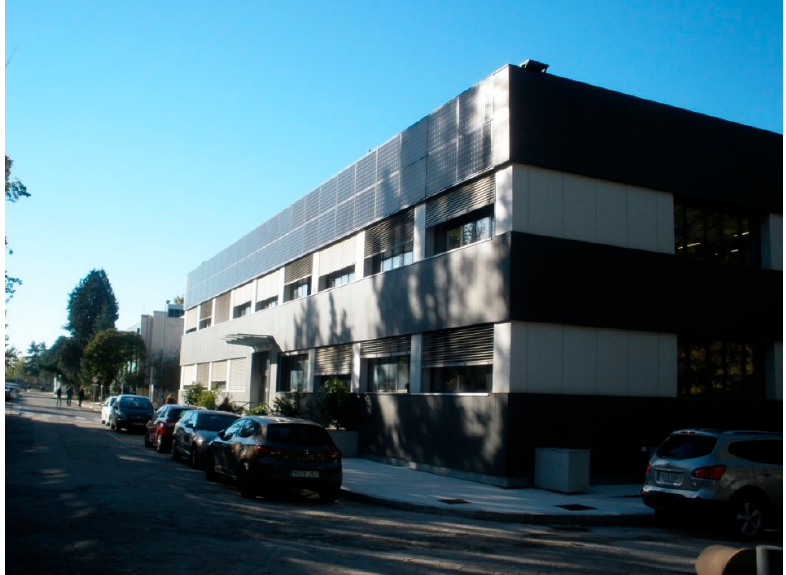
Figure 10. Partial shading by the trees of the east façade.